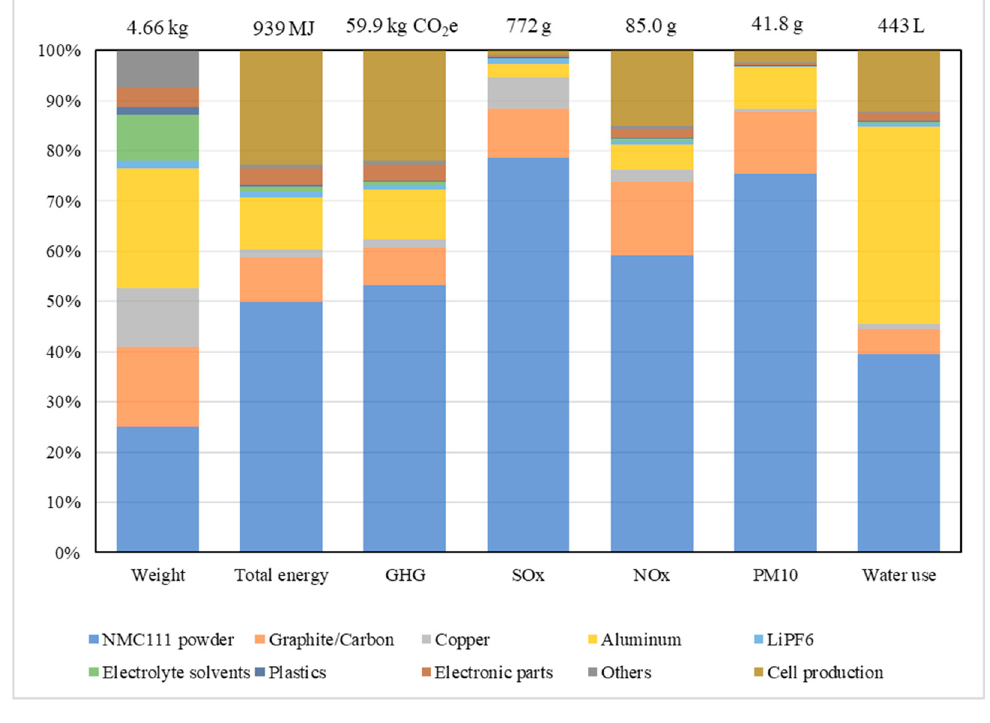
Figure 6. Cradle-to-gate environmental impacts: 1 kWh NMC111 cells.